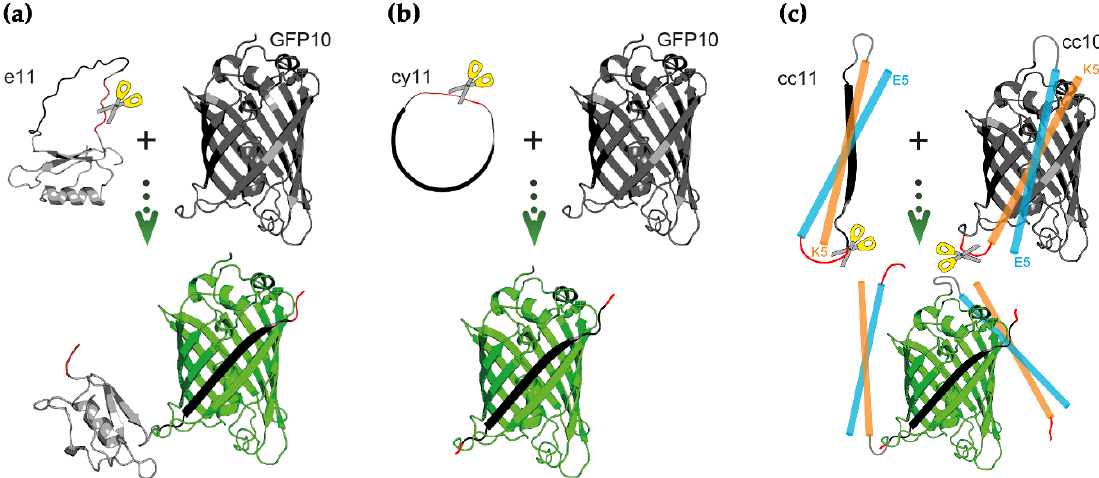
Scheme 1. Schematic illustrations of the switch-on split fluorescent proteins activated by proteolysis. ( a ) GFP11 fragment is embedded as a surface loop on the small protein eglin c—e11 strategy. ( b ) GFP11 fragment is cyclized by Nostoc punctiforme DnaE split intein—cy11 strategy. ( c ) GFP10 and GFP11 fragments are flanked by α -helical heterodimeric E5/K5